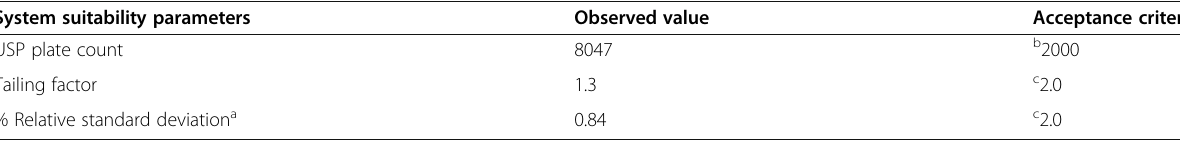
Table 6 System suitability study